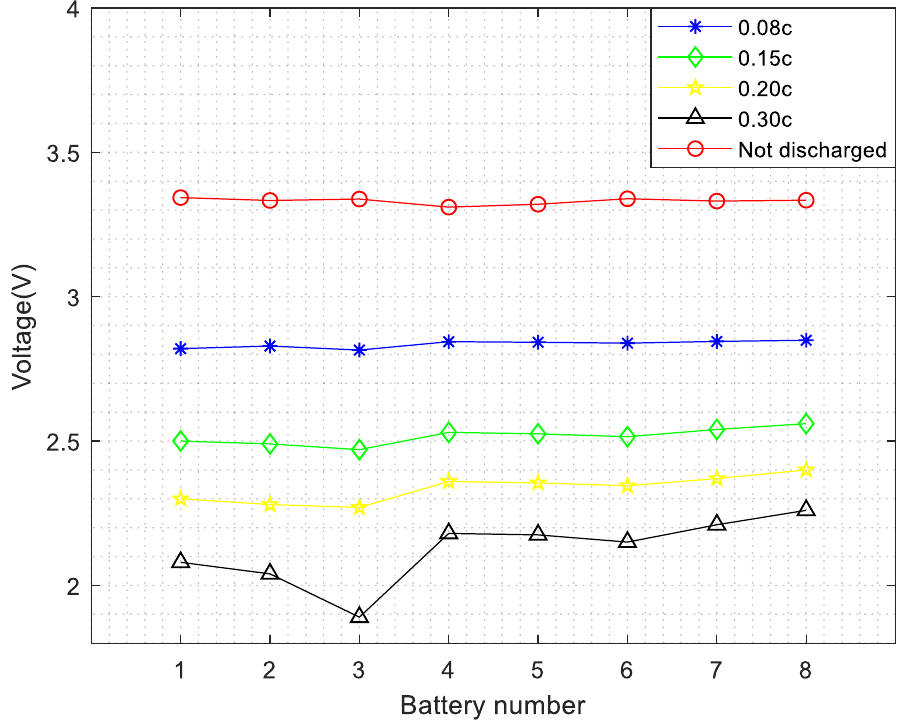
Figure 4. The voltage difference between individual cells at different discharge rates.